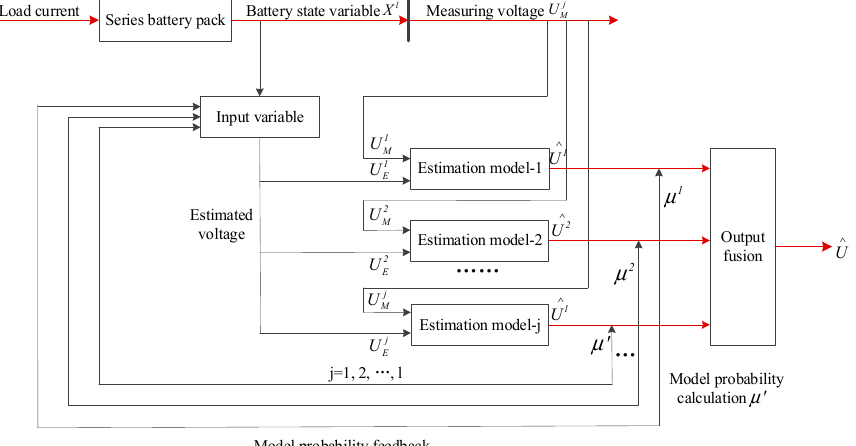
Figure 6. Overall flow chart.